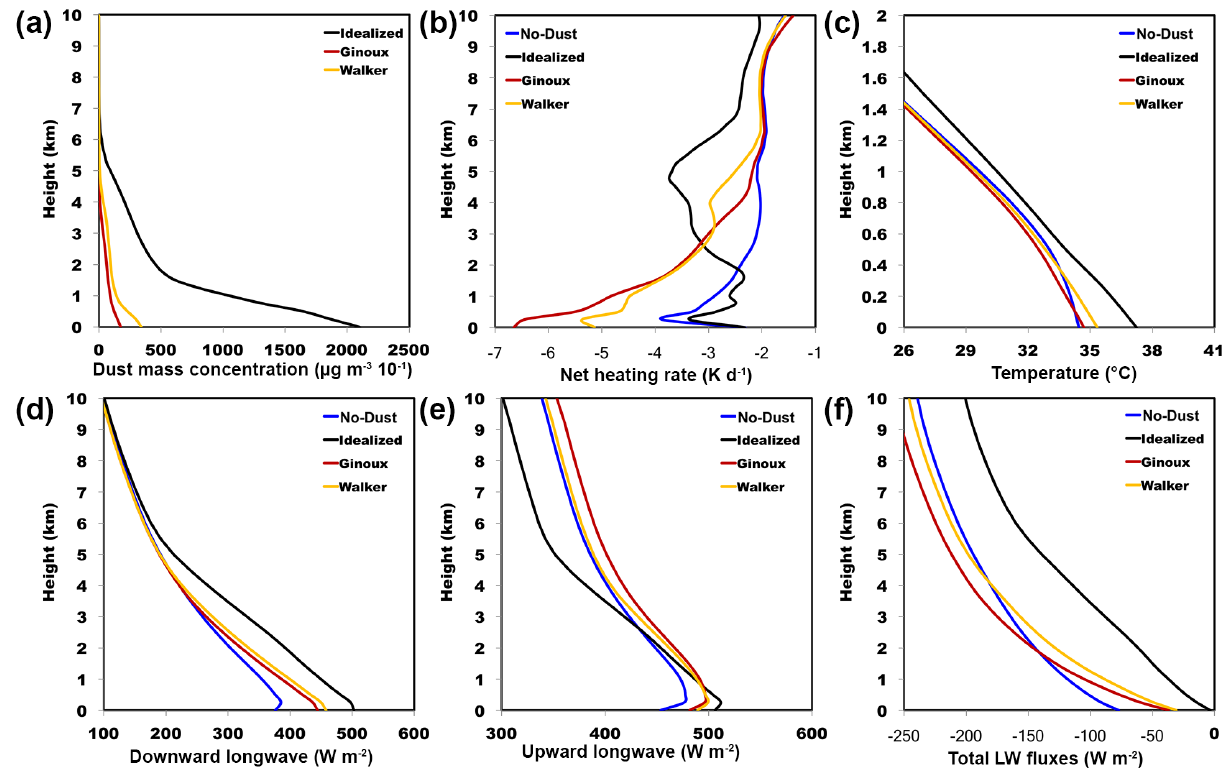
Figure 10. Nighttime 02:00UTC ( ∼ 06:00LST) vertical profiles on 4 August of analysis-area-averaged (a) dust mass concentration (µgm − 3 × 10 − 1 ), (b) net radiative heating rate (Kd − 1 ) , (c) temperature (C ◦ ), (d) downward longwave (Wm − 2 ) , (e) upward longwave (Wm − 2 ) , and (f) total radiative fluxes (Wm − 2 ) computed as the sum of shortwave and longwave and downward minus upward fluxes. Note that panel (c) is on a different vertical scale so as to zoom in on lower-level